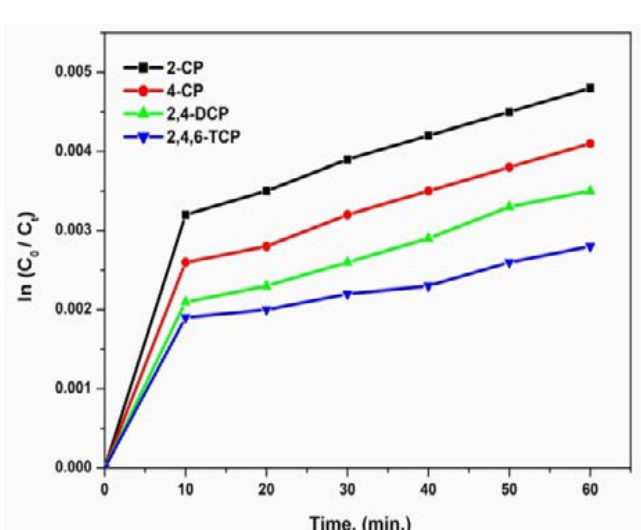
NPs under sunlight 2